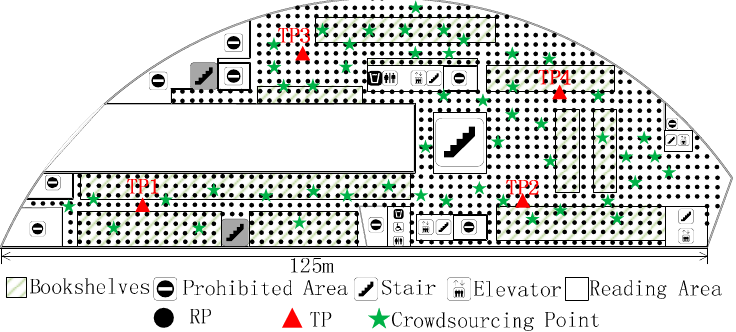
Figure 7. The distribution of RPs, target points (TPs), and crowdsourcing-based points in the experimental area.